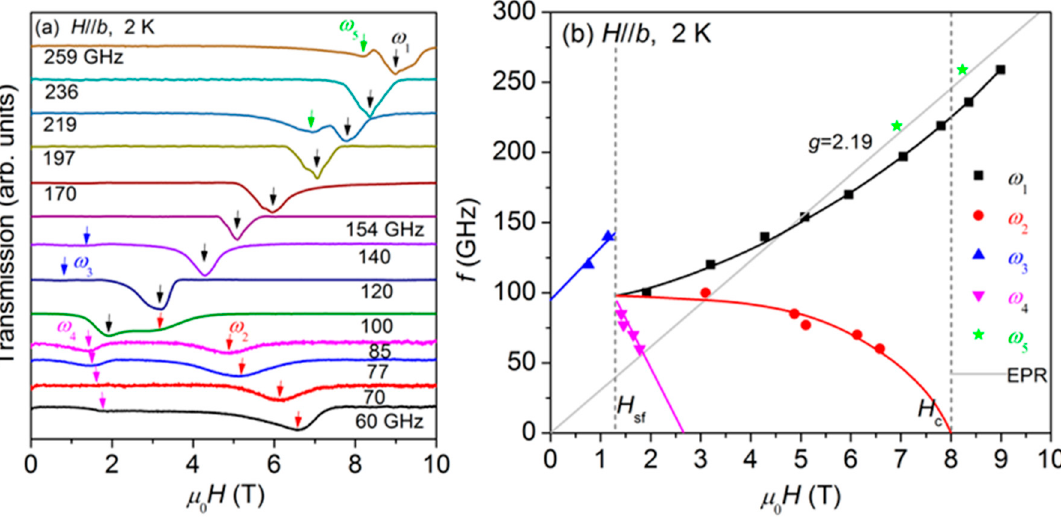
Figure 5. ( a ) Frequency-dependent ESR spectra measured at 2 K for the easy b axis. ( b ) Frequency-field ( f - H ) relationship at 2 K as well as the EPR line. The solid lines are guides for the eyes.